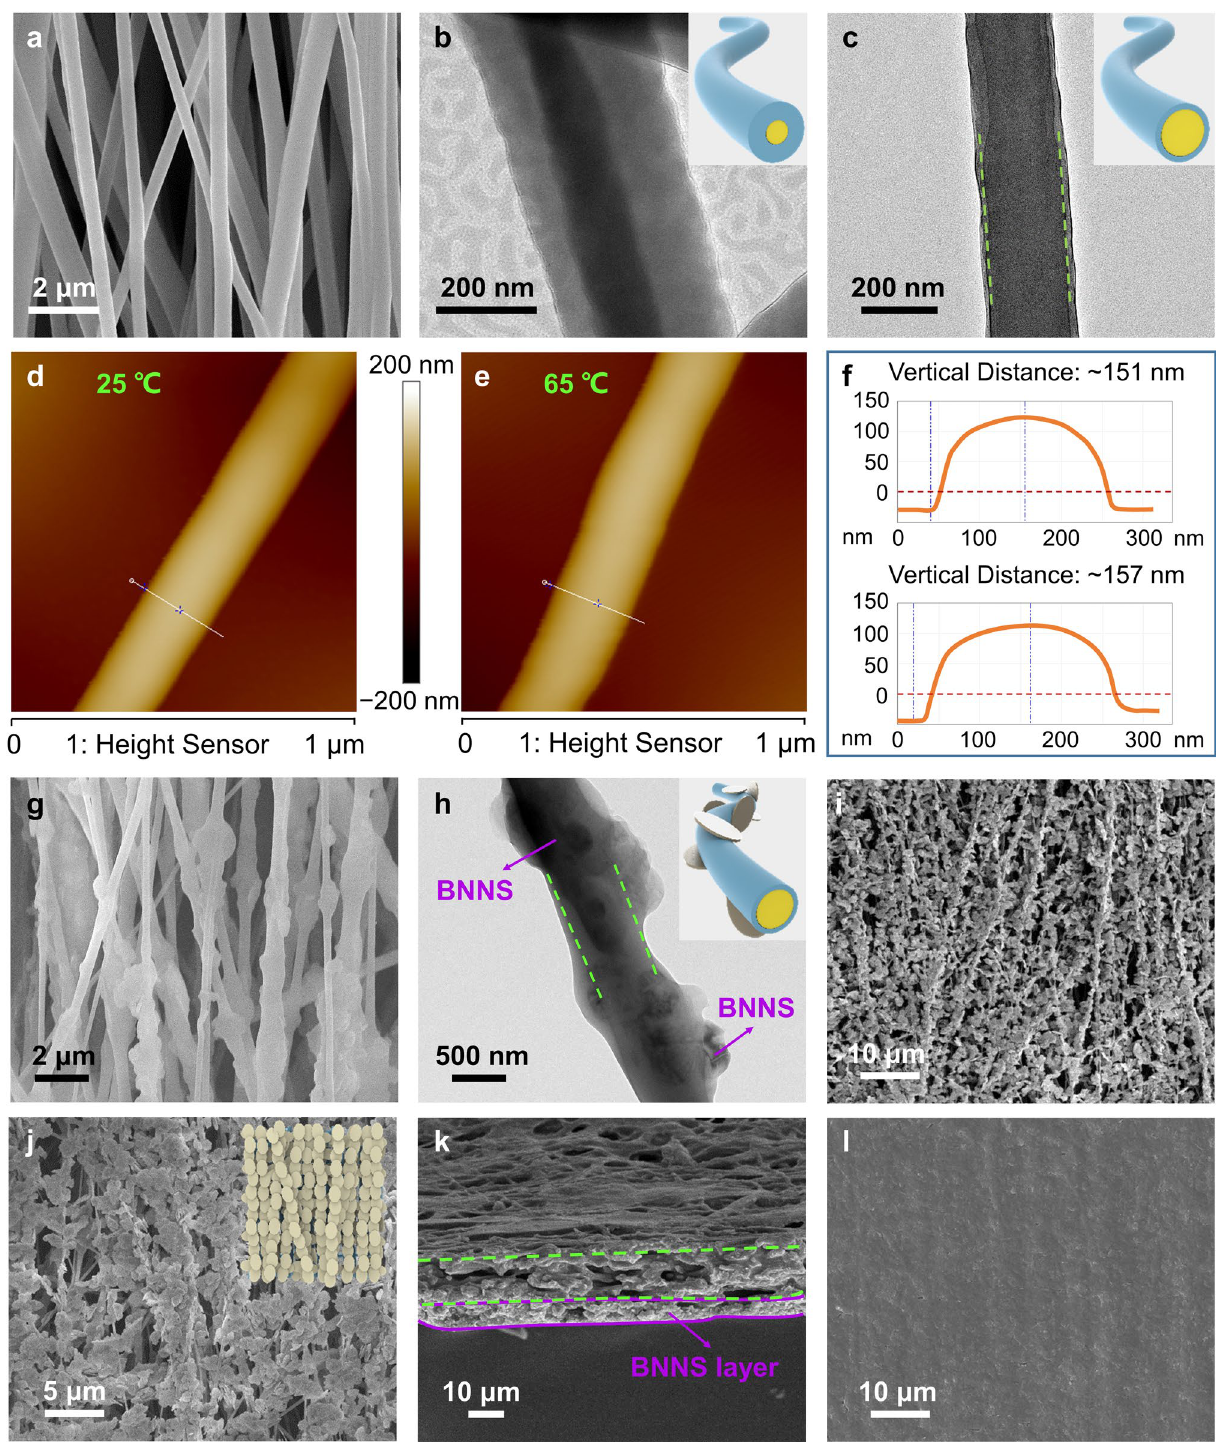
Fig. 2 Microstructure characterization. a SEM image of PEG@TPU fibers. b , c TEM images of PEG@TPU fibers with different mass ratios of PEG to TPU, the insets at the top right are diagrams of the corresponding core–sheath fibers. d, e AFM images of the PEG@TPU fiber tested at 25 and 65 °C. f Correspond- ing AFM data of the PEG@TPU fiber at 25 (top) and 65 °C (bottom). g SEM image of PEG@TPU/BNNS fibers. h TEM image of a PEG@TPU/BNNS fiber, the inset is a diagram of the core–sheath nanocomposite fiber. i , j SEM images of PEG@TPU/BNNS-es fibrous membrane, the inset in j is the diagram of the corresponding fibrous membrane. k , l SEM images of the cross section and surface of the PEG@TPU/BNNS-es nanocomposite film,